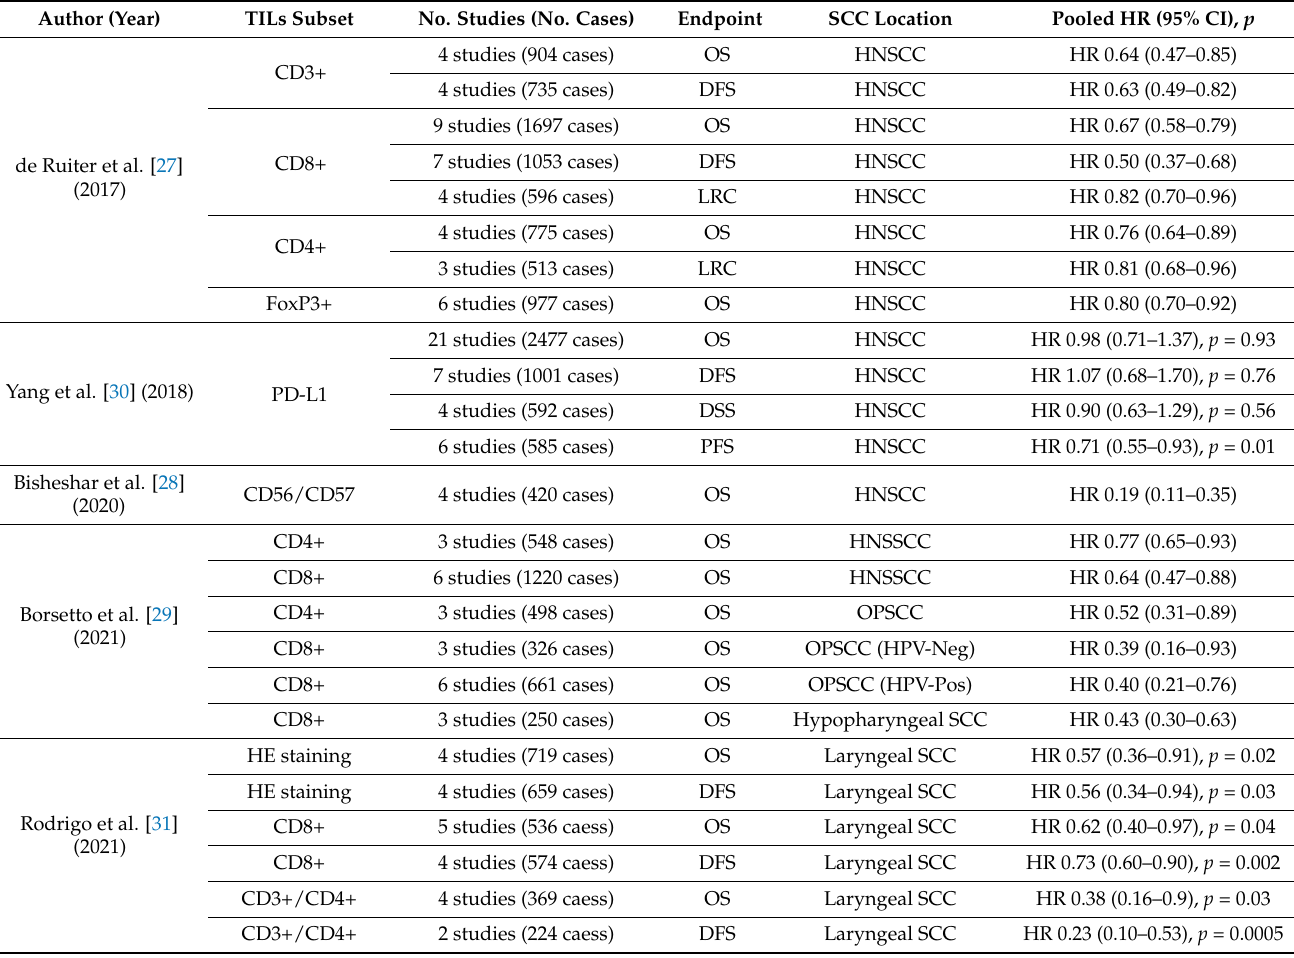
Table 1. Summary of meta-analyses on TILs in